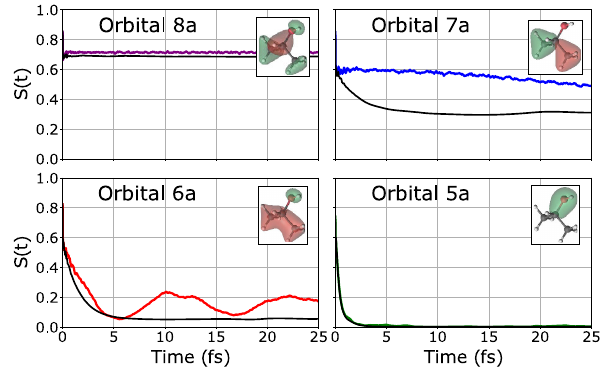
FIG. 5. Hole survival probability of different hole states arising from removal of an electron from (neutral) inner valence orbitals 8 a (purple, outermost) to 5 a (green, innermost) after sudden ionization of isopropanol. The colored survival probability curves correspond to a mixture ( 1 ∶ 1 ) of the two lowest conformers of the molecule. The black curves correspond to the averaged dynamics over 500 geometries at a temperature of 300 K. The Hartree-Fock orbitals of the neutral are shown in insets for the gauche